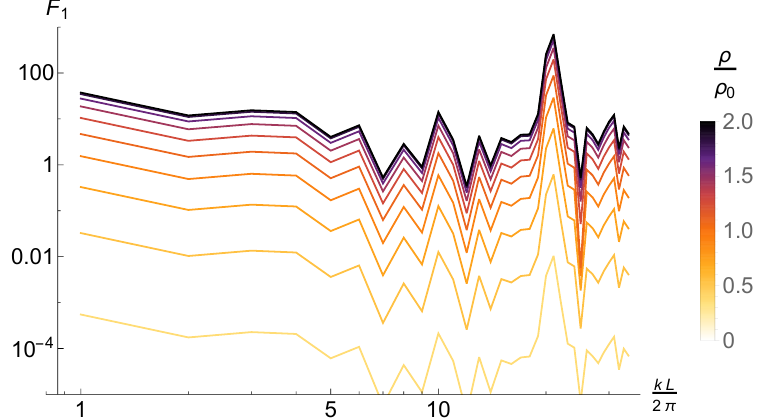
P F 1 ~n ( ρ, t ) e i 2 π~n L · ~x , the t , x 1 , ~n L 2 ~k | L R F ( ρ, t ) | dθ , at time 2 π ρ 2 0 1 | ~k | L 2 π